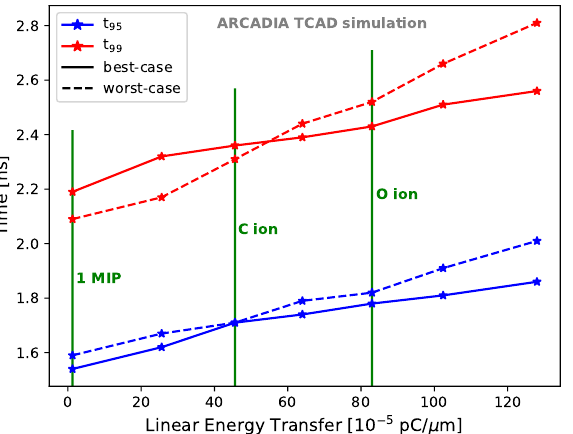
Figure 22. t 95 (blue) and t 99 (red) as a function of the LET for best-case and worst-case scenarios. In a strip readout system, timing information can be retrieved only from the strips collecting most of the charge (i.e., strip(s) number 1, following the nomenclature of Figure 8), as they provide a signal with sufficiently large SNR. Therefore, in order to study the sensor timing performance and after verifying through t 95 that the total deposited charge is quickly collected in the whole simulation domain, we considered the time t central needed to collect 95 95% of the charge in the central strip(s).